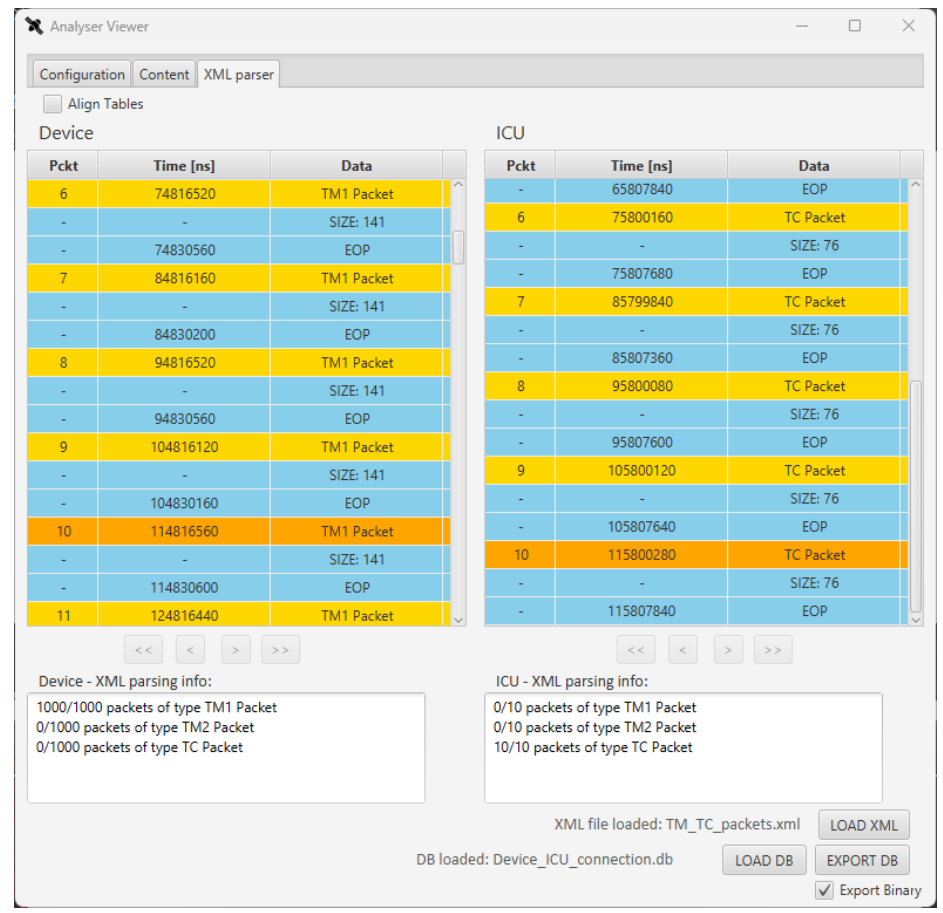
Figure 12. SpaceART Sniffer GUI visualization of packets filtered by means of SpW